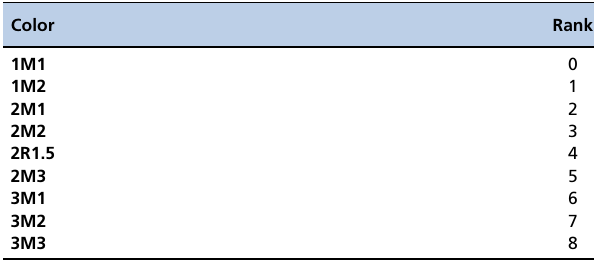
Figure 1 - Flowchart of the study based on CONSORT (17) recommendations. Table 1 - Demographic data of the